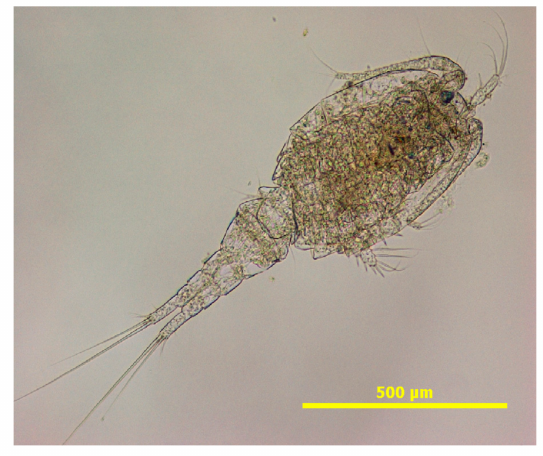
Figure 1. Female of Diacyclops belgicus at the optical